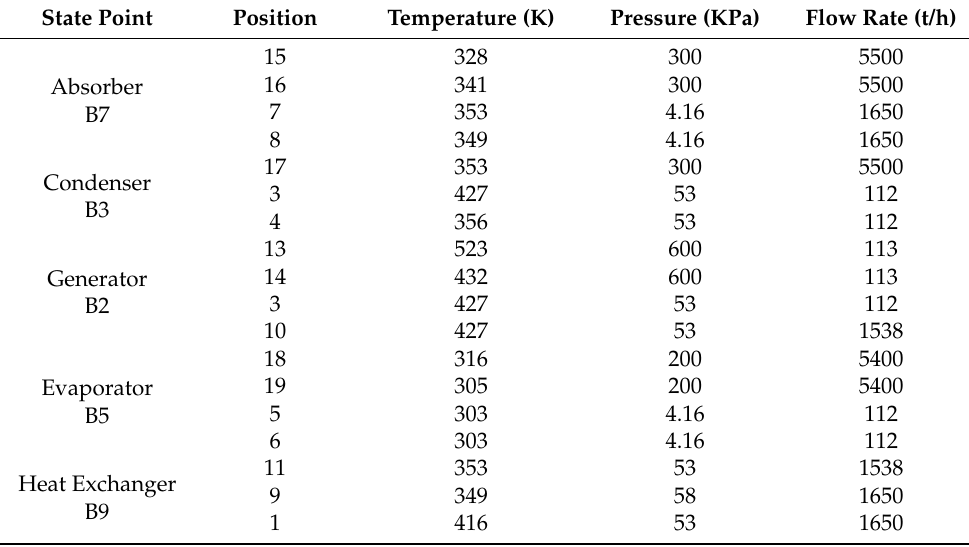
Table 2. Typical stream result in the Aspen Plus